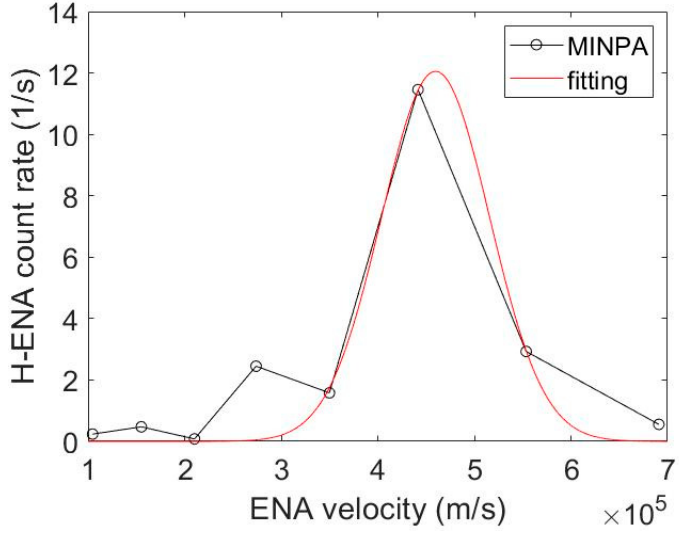
Figure 8. The SW H-ENAs observed by MINPA, and Gaussian fi tt ing. Black line with circles represents the observed count rate of the SW H-ENAs. Red line represents fi tt ing.